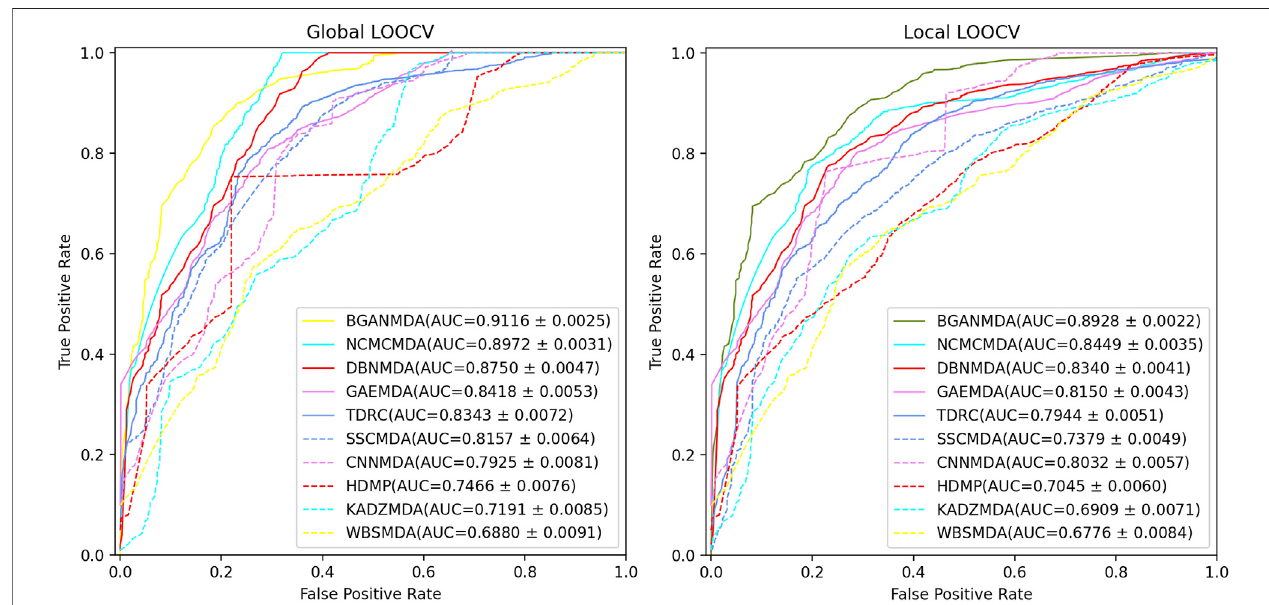
FIGURE 3 | The performance of BGANMDA and the other nine disease-related miRNA prediction methods, namely NCMCMDA, DBNMDA, GAEMDA, TDRC, SSCMDA, CNNMDA,HDMP, KADZMDA and WBSMDA, werecomparedbased onthe ROCcurveand theAUC value inglobaland local LOOCV. BGANMDA obtained the AUC and standard deviation of 0.9116 ± 0.0025 in global LOOCV and 0.8928 ± 0.0022 in local LOOCV,